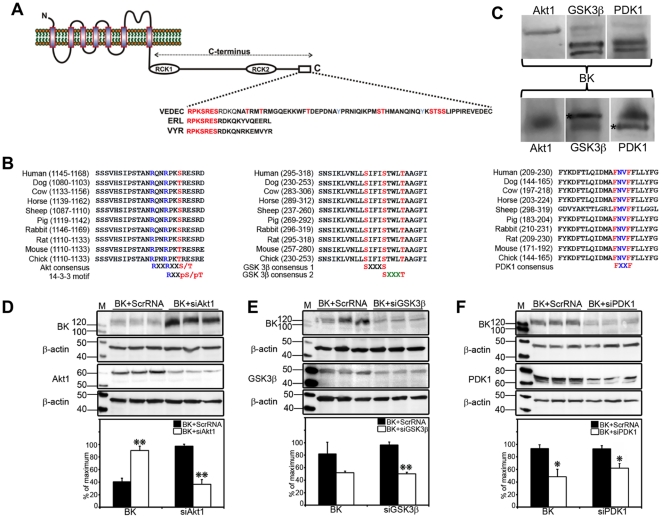
Putative binding sites for life/death signals alter BK expression.(A,B) The BK C-terminus of 10 different vertebrates has putative binding sites for Akt1, 14-3-3γ, GSK3β, and PDK1. (C) Akt1, PDK, and GSK3β interact with BK, as verified by reciprocal coIP using total cochlear lysate. Label above photos indicate antibody used for coIP, whereas the label below photos indicate the protein coimmunoprecipitated. Akt1 coimmunoprecipitated one isoform of BK (130 kDa), whereas GSK3β and PDK1 coimmunoprecipitated multiple isoforms (90–130 kDa). In the reciprocal experiment, BK coimmunoprecipitated Akt1 (56 kDa), GSK3β (47 kDa), and PDK1 (63 kDa). The IgG band is signified by an (*). (D–F) CHO cells were transfected with HA-BK and scRNA, or HA-BK and siRNAs for Akt1, PDK, and GSK3β. HA-BK increased with knockdown of Akt and decreased with knockdowns of GSK3β and PDK1. Densitometry measurements were normalized and statistical significance determined in D–F as in Figure 5 to obtain *, p<0.01, **, p<0.001. Error bars represent the S.D.